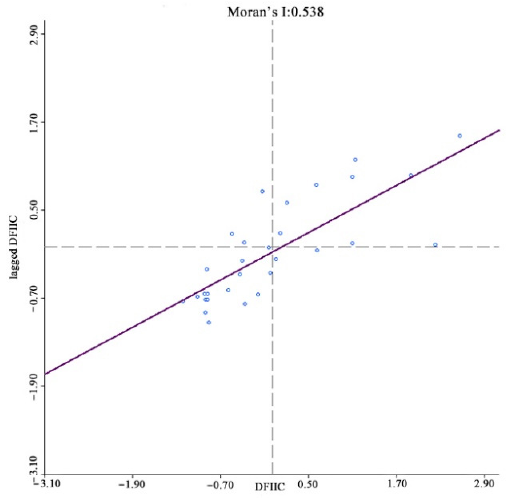
Figure 5. Global Moran’s I of digital inclusive finance growth.